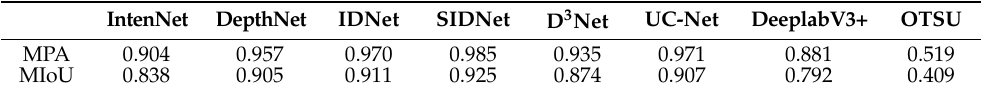
Figure 12. Experiment results of testing different MAE threshold values to obtain the optimal trained model. Table 2. Statistical results of different algorithms for segmenting spalling